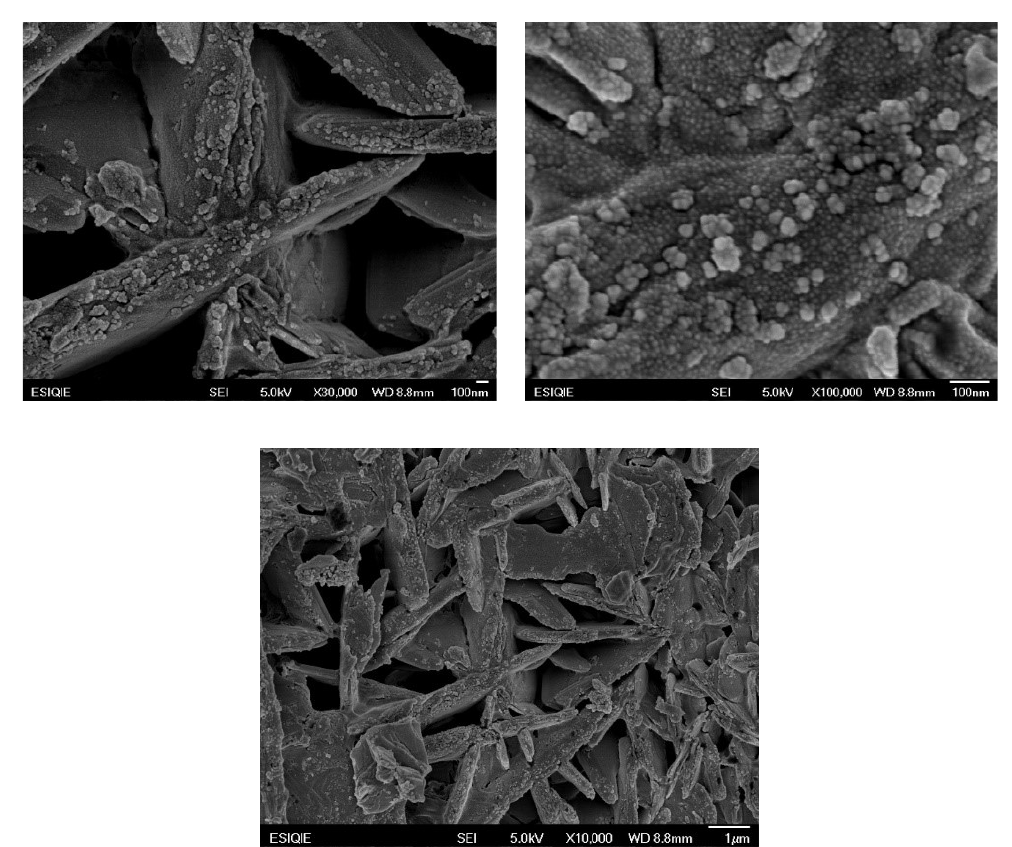
Figure 4. SEM micrographs of the as-prepared boehmite